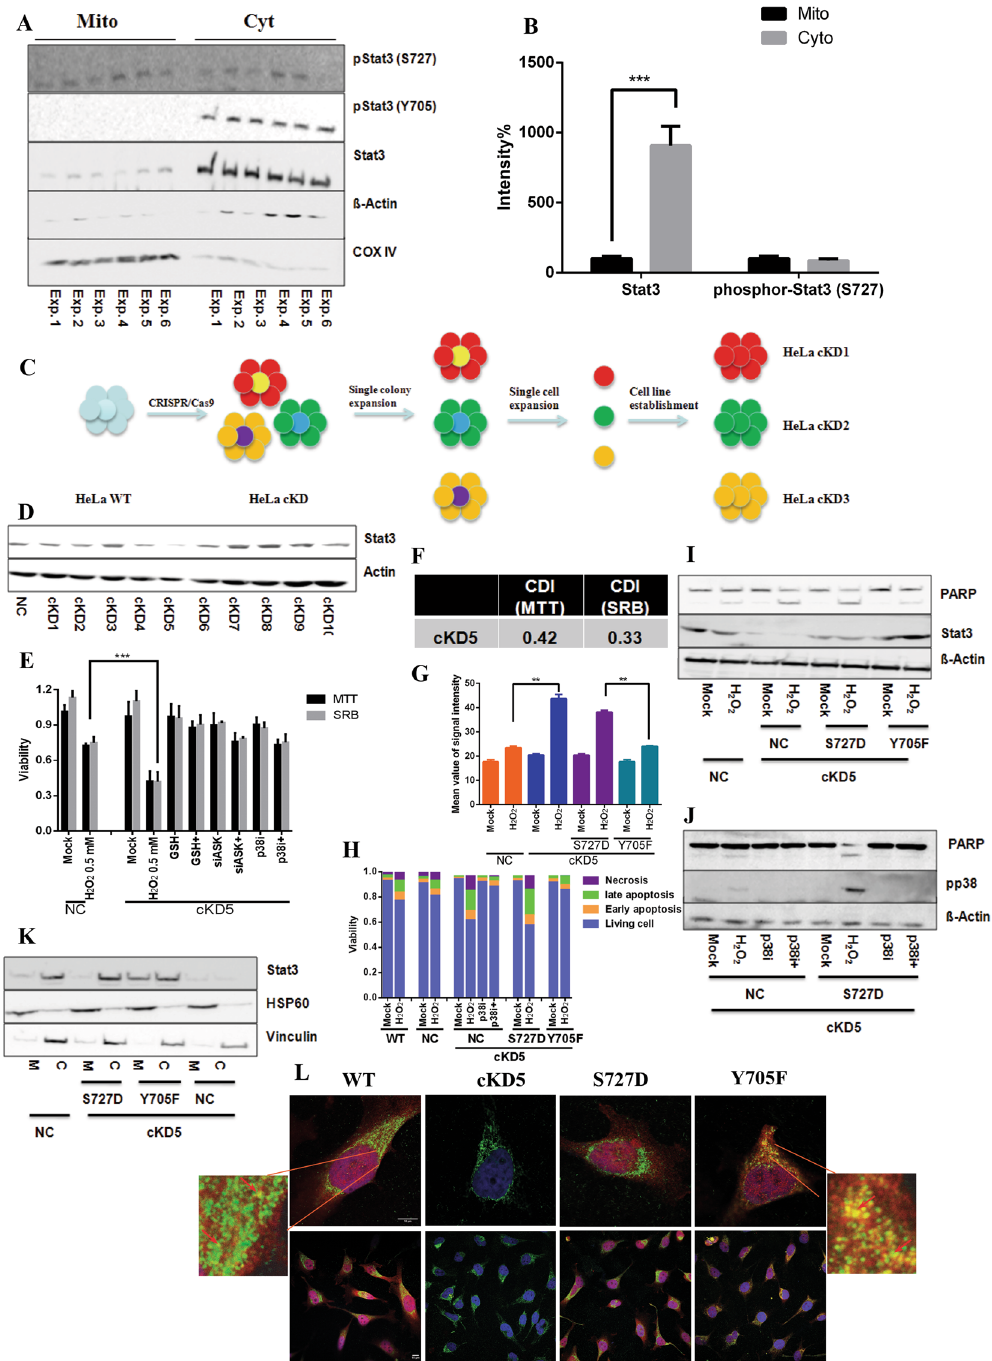
Figure 3. Loss of functional mitochondrial Stat3 is essential to enhance cell sensibility to oxidative stress. ( A ) and ( B ) Mitochondrial and cytosolic fractions were isolated from HeLa cells to compare the concentrations of Stat3, phospho-Stat3 Y705 and phospho-Stat3 S727 by immunoblotting in six independent experiments. Signal intensities were quantified and normalized to corresopnding proteins in the mitochondrial fraction. ß-actin and COX IV were used for loading control. ( C ) Schematic illustration: the generation of CRISPR/Cas9 mediated Stat3 knockdown cell lines (HeLa cKDs) with signle cell expansion. ( D ) The knockdown effect of HeLa cKDs. ( E ) GSH, ASK siRNA (siASK) and p38 inhibitor (p38i) sufficiently blocked the synergistic toxic effect by H 2 O 2 in cKD5 cells measure by MTT and SRB assays. ( F ) Coefficient of drug interaction (CDI) was calculated. ( G ) Overexpression of Stat3 Y705F , but not Stat3 S727D rescued H 2 O 2 -induced ROS formation in cKD5 cells. ( H ) Adding p38 inhibitor (p38i) and overexpression of Stat3 Y705F , but not Stat3 S727D prevented cellular apoptosis induced by H 2 O 2 in cKD5 cells. ( I ) Overexpression of Stat3 Y705F , but not Stat3 S727D blocked PARP cleavage induced by H 2 O 2 in cKD5 cells. ( J ) Adding p38 inhibitor (p38i) sufficiently inhibited phospho-p38 MAPK and cleavage of